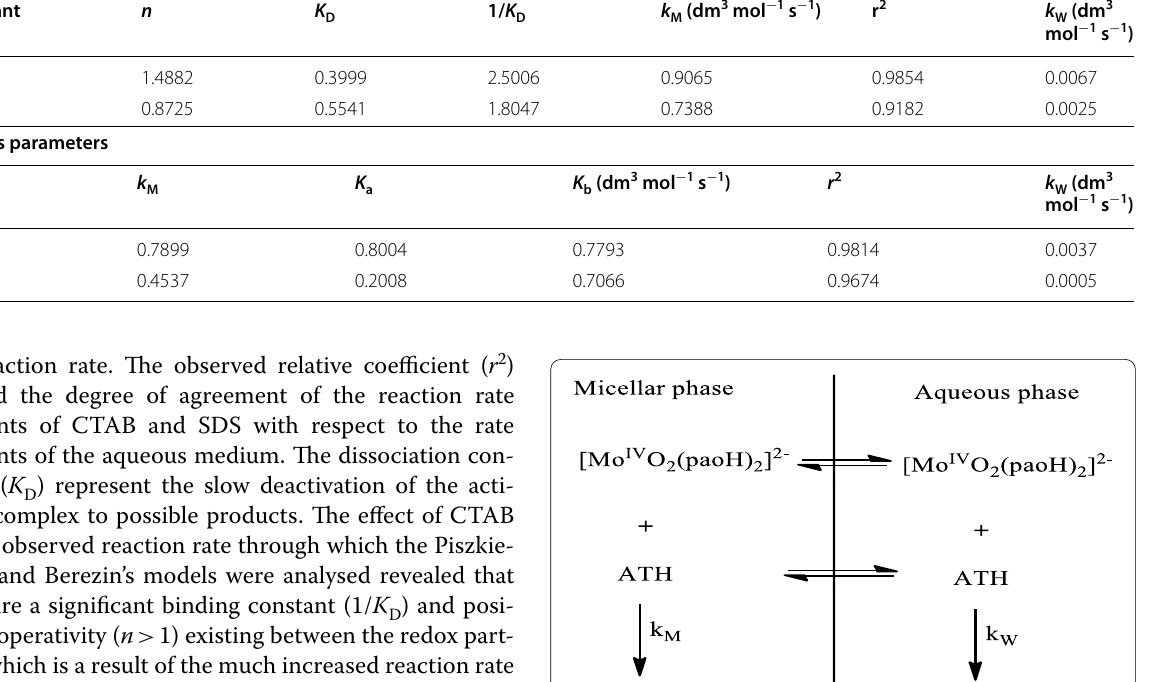
Table 4 Piszkiewicz’s and Berezin’s model parameters Piszkiewicz’s parameters